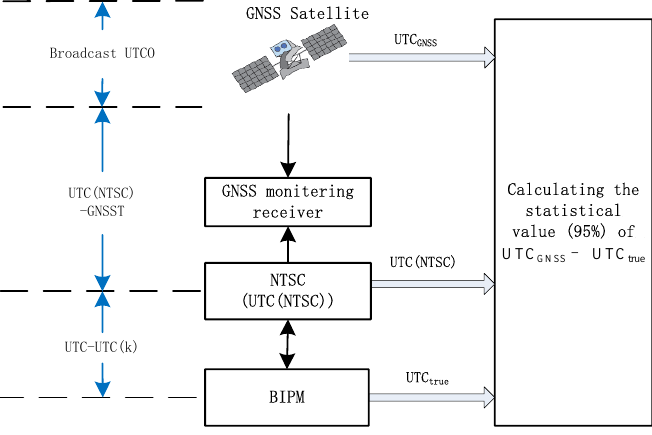
Figure 2. Principle of GNSS time transfer accuracy assessment.